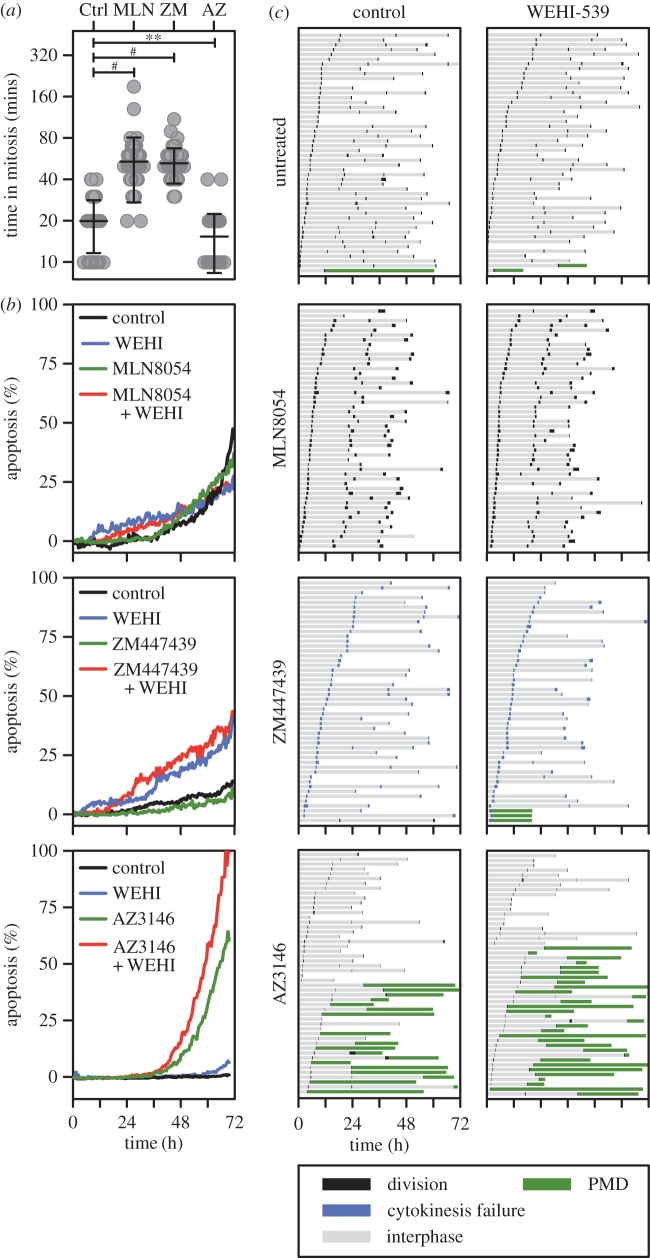
WEHI-539 only has a minor impact when combined with mitotic drivers. (a) Scatter plot quantitating the time RKO cells spent in mitosis following exposure to 250 nM of the Aurora A inhibitor MLN8054, 2 µM of the Aurora B inhibitor ZM447439 and 2 µM of the Mps1 inhibitor AZ3146. **p < 0.01, #p < 0.0001. (b) Line graphs showing apoptosis induction following exposure to the drugs indicated in (a) plus 100 nM WEHI-539. (c) Cell fate profiles of cells treated as in (b). Zero hours on the fate profiles represents when imaging started.